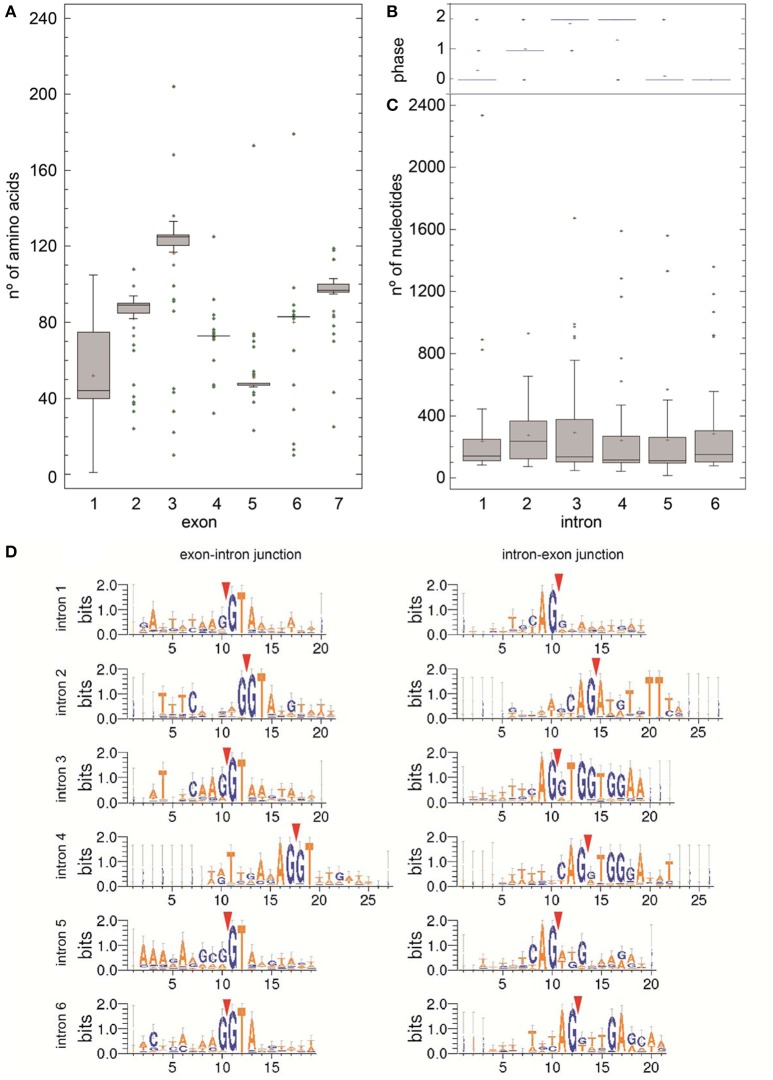
Exon and intron characteristics of putative 55 full-length CsTPSs. (A) Representation of exon length variation (in amino acids) among CsTPSs analyzed. (B) Representation of intron phase variation among CsTPSs analyzed. (C) Representation of intron length variation (in nucleotides) among CsTPSs analyzed. (D) Sequence conservation and splice position (indicated by red triangles) were calculated using WebLogo7 server in basis of annotated information from 55 putative CsTPS genes. In ordinate axis the height of the letters reflects the relative frequency of each nucleotide at each position.